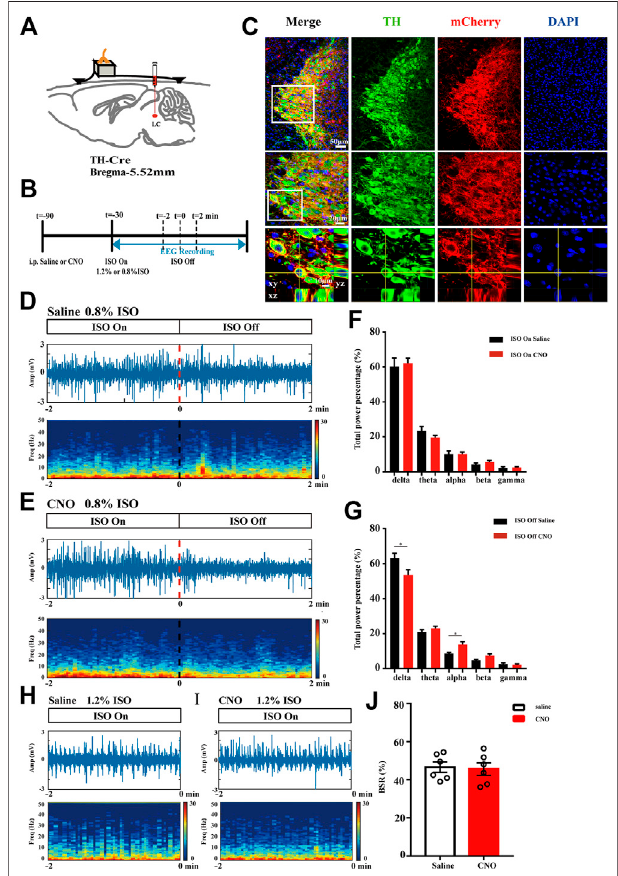
FIGURE 3 | LC TH neurons activation drives cortical arousal. (A) Schematic diagram showing bilateral virus injection and EEG recording. (B) Timeline for EEG recording during iso fl urane anesthesia and emergence in hM3Dq mice injected i. p. with CNO or saline. (C) Speci fi c expression of hM3Dq-mCherry (red) in LC TH (green) neurons. Insets were ampli fi ed in below. (D,E) A representative raw EEG trace (top) and the corresponding power spectrogram (bottom) during 0.8% iso fl urane anesthesia and emergence period in hM3Dq-saline (D) and hM3Dq-CNO (E) mice. 0 on the time axis indicates the cession of iso fl urane. (F) Power spectrum analysis was conductedon2 minwindowbeforecessionofiso fl uraneinhM3Dq-salineand hM3Dq-CNO mice ( n (cid:1) 6 in each group, the two-tailed unpaired t-test). (G) In the emergence period, power spectrum analysis was conducted from 0.8% iso fl urane inhalation stop to 2 min window ( n (cid:1) 6 in each group, the two-tailed unpaired t-test, * p < 0.05). (H,I) A representative raw EEG trace (top) and the corresponding power spectrogram (bottom) during 1.2% iso fl urane anesthesia in hM3Dq-saline (H) and hM3Dq-CNO (I) mice. (J) In the anesthesia period, BSR was calculated at 2 min window before cession of iso fl urane in hM3Dq-saline and hM3Dq-CNO mice ( n (cid:1) 6 in each group, the two-tailed unpaired t-test). Data shown as means ±